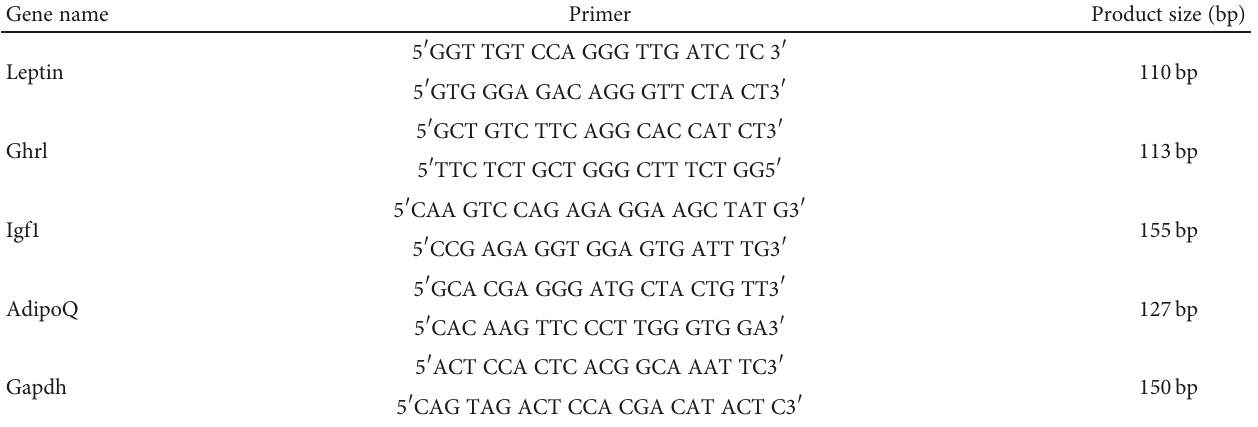
Table 1: The information of the primer pairs used for the analysis of gene expression levels by qPCR.